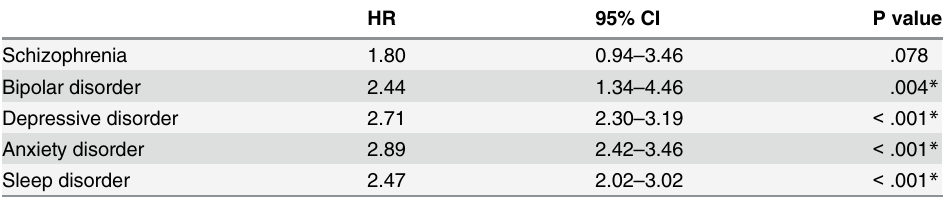
Table 3. Hazard ratios of time until diagnosis of psychiatric disorders between patients in the IBS and control cohorts during a 10-year follow-up